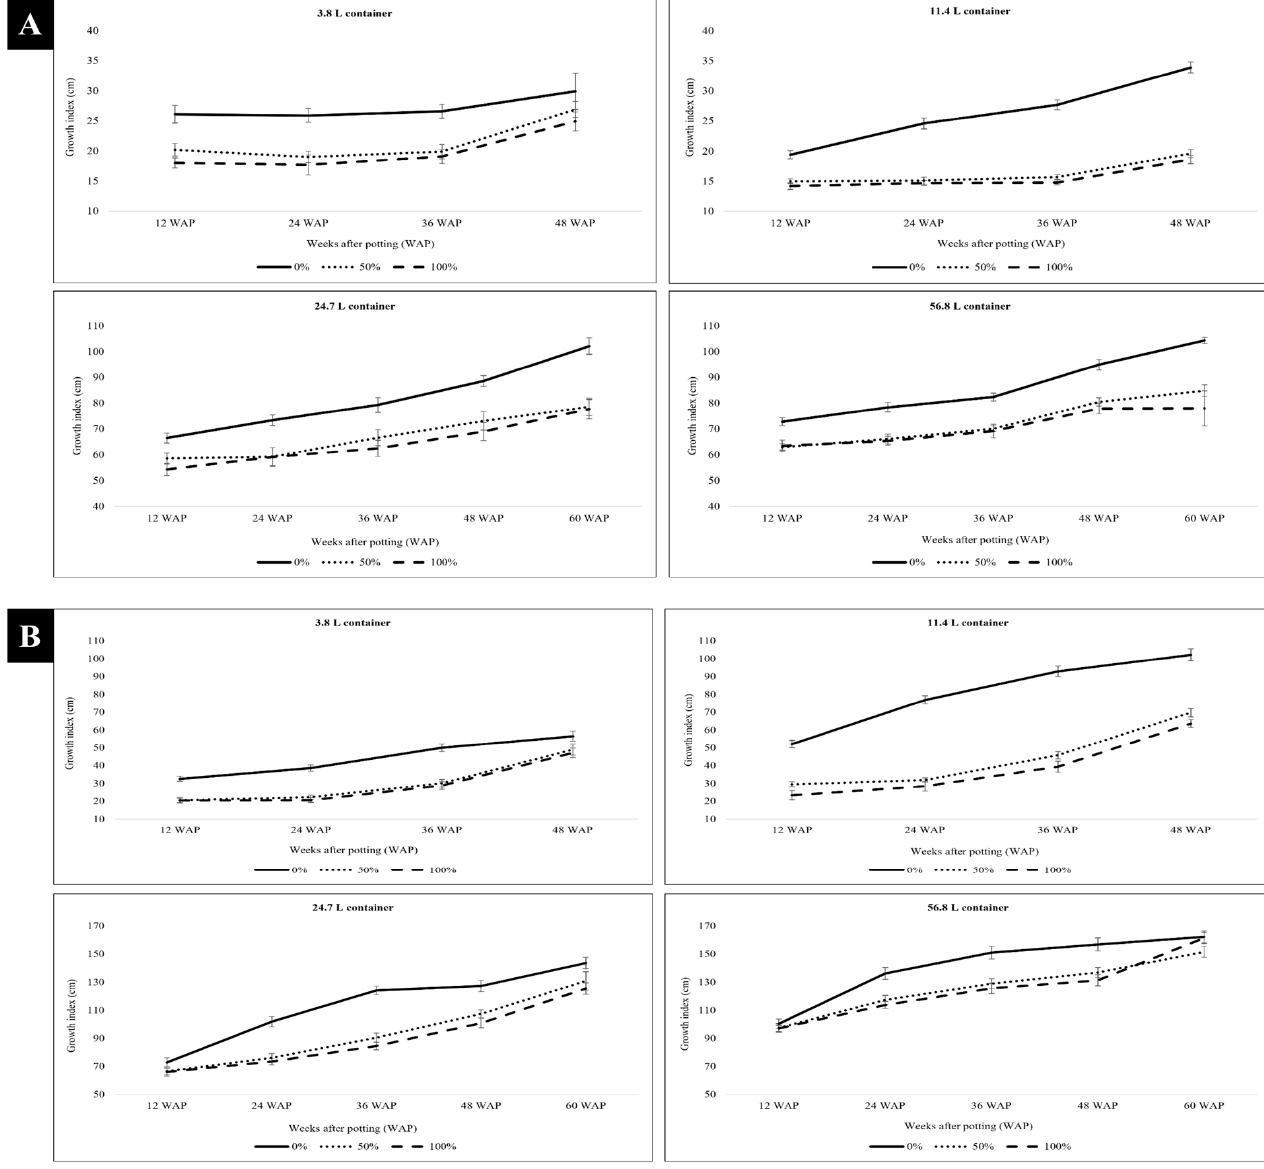
Figure 2. Figure ( A ) represents the growth index of Japanese holly and figure ( B ) represents the growth index of ligustrum in 3.8 L, 11.4 L, 24.7 L, and 56.8 L container at weed coverage levels of 0%, 50%, and 100%. Growth index (cm) was determined by calculating [(height + width at widest point + perpendicular width) ÷ 3] from 0 to 48 weeks after planting (WAP) for plants growing in 3.8 L and 11.4 L containers and from 0 to 60 WAP for plants in 24.7 L and 56.8 L containers. Error bars represent standard errors. For plants in 3.8 L containers, this reduction in growth was continually observed at 24 and 36 WAP, but at the conclusion of the experiment at 48 WAP, no difference in the growth index was observed among the treatments. For plants in 3.8 L containers, the growth reduction resulting from 50% and 100% competition levels followed a quadratic trend in which the greatest growth reduction was observed at 24 and 36 WAP and declined thereafter, indicating that competition effects were first low and then increased and decreased as plants reached their maximum size (Table 2).